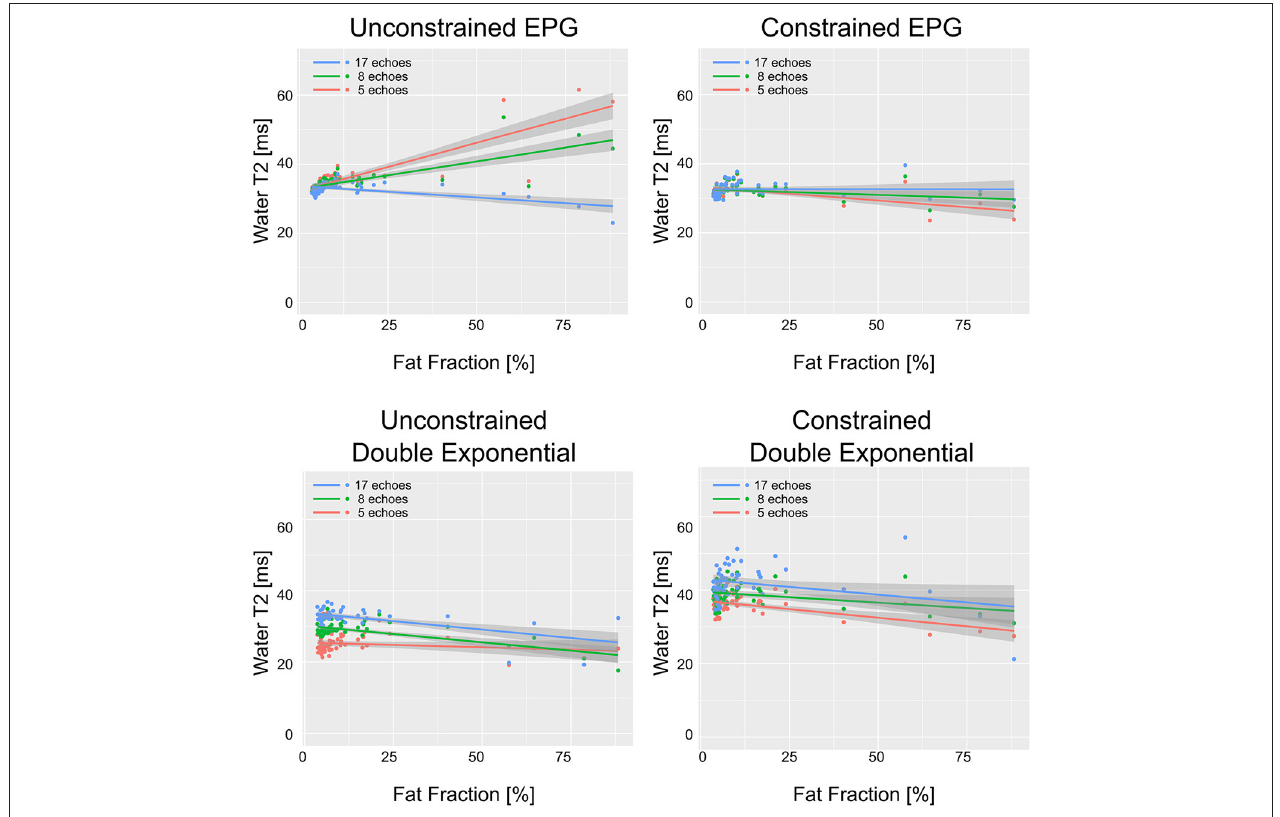
FIGURE 3 | wT2 values over each ROI vs. fat fraction in the same ROI, for all ROIs drawn in patients and healthy volunteers. The solid lines represent the linear regression with shaded gray areas indicating the 95% confidence